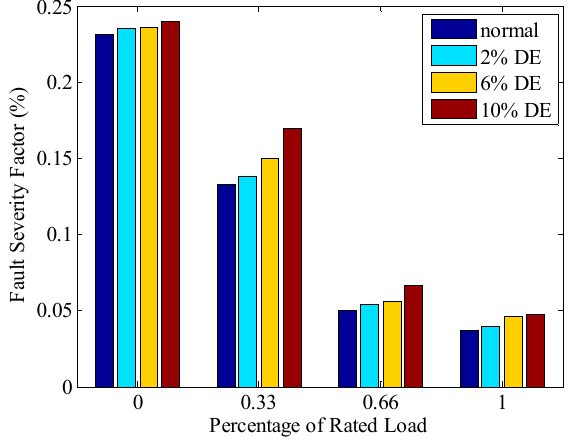
Figure 12. FSF variation of harmonic components versus different loads at the healthy motor and motors with different DE levels.